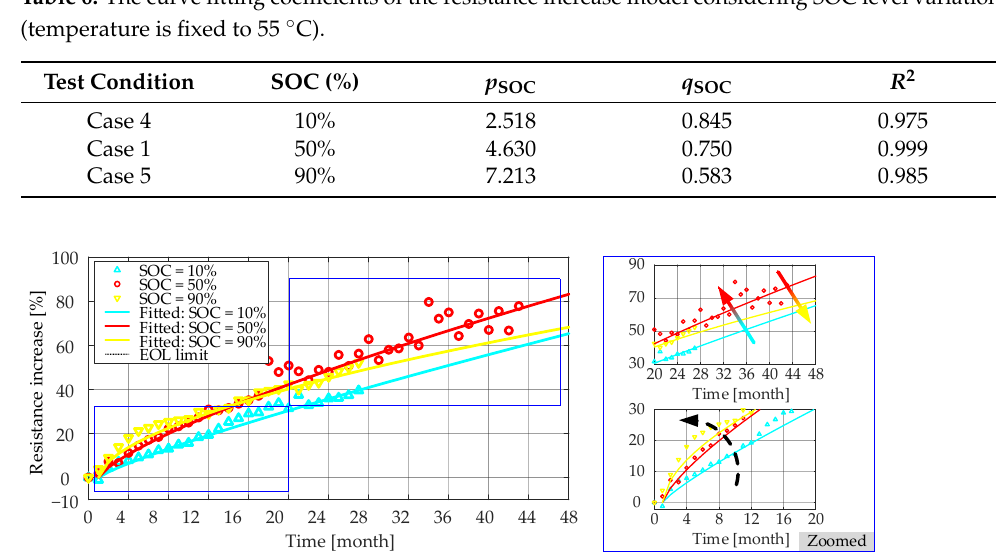
( b ) Figure 18. The relationship between the curve fitting coefficients and the corresponding storage temperature. ( a ) Exponential relationship between a SOC and SOC , ( b ) Exponential relationship between b SOC and SOC .